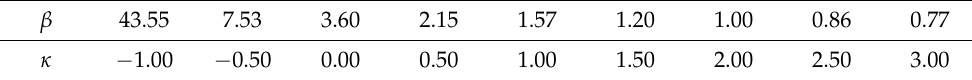
Table 1. Parameters and the corresponding levels of skewness of a Weibull